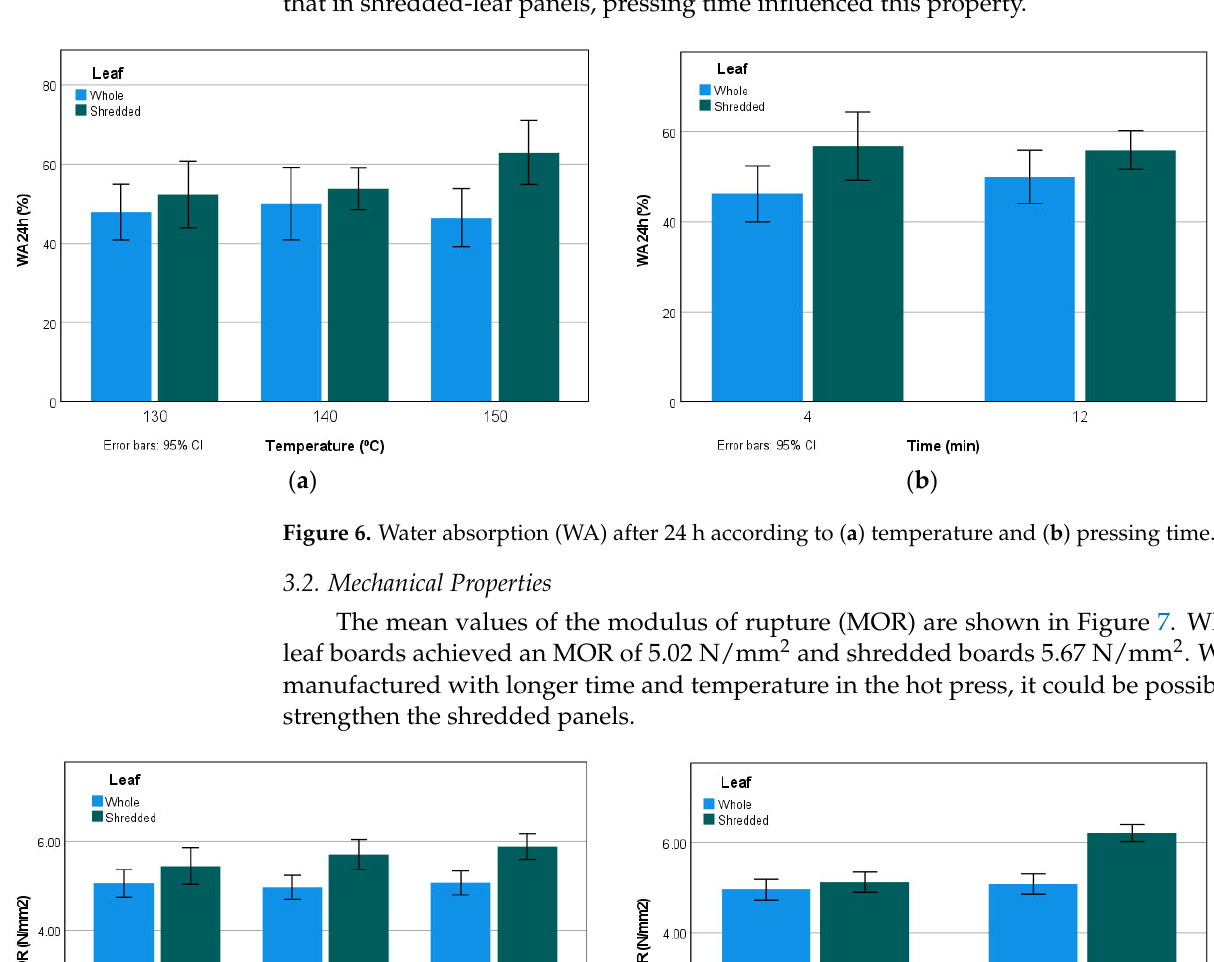
Figure 5. Thickness swelling (TS) after 24 h according to ( a ) temperature and ( b ) pressing time.